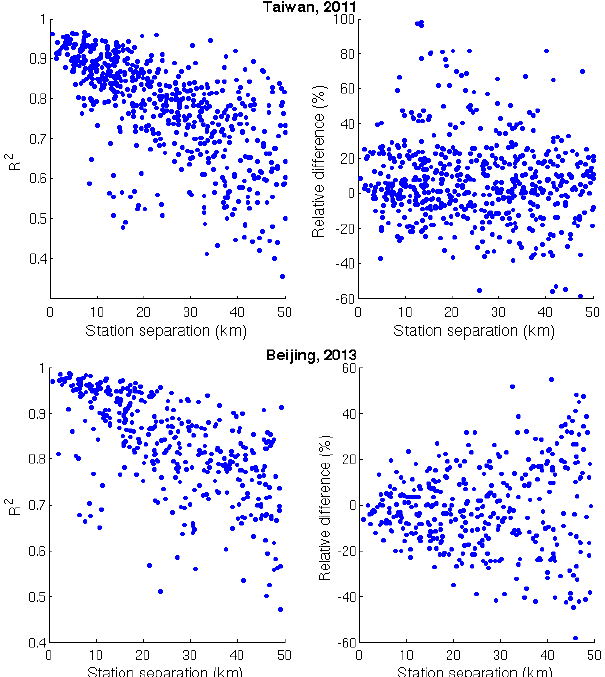
Figure A1. PM 2 . 5 relationships between pairs of stations in Taiwan (calendar year 2011) and Beijing (calendar year 2013). There were 76 stations available in Taiwan for comparison and 36 available in Beijing.